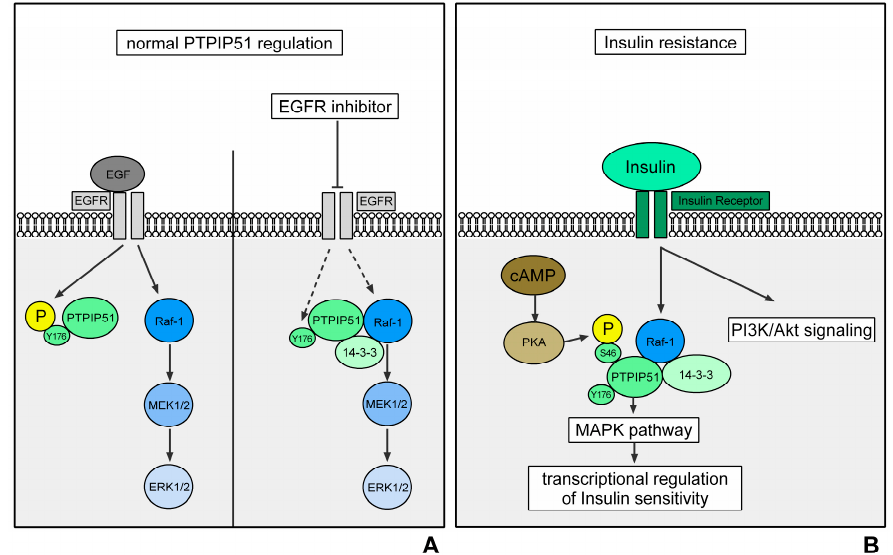
Figure 1. Regulation of PTPIP51 interactions in normal cells (represented by the HaCat cell line). Activation of the EGFR via the binding of EGF induces an activation of Raf-1 via several signaling molecules. Raf-1 depicts the MAPKKK of the ERK signaling. Its activation triggers a signaling cascade via MEK1/2 and ERK1/2, which ultimately initiates transcription. The EGFR also phosphorylates the Tyr176 residue of PTPIP51 and thereby inhibits its interaction with Raf-1. This mechanism prevents an overshooting activation of the MAPK pathway. The right side of the figure represents the interactions when EGFR is inhibited. The inhibition of EGFR leads to an omission of Tyr176 phosphorylation of PTPIP51 via the EGFR. The dephosphorylation of PTPIP51 at Tyr176 induces the formation of the Raf-1/14-3-3 β /PTPIP51 complex and thus a stimulation of the MAPK pathway. This mechanism partially compensates for the EGFR inhibition (black arrows indicate a phosphorylation/activation; dotted black arrows indicate a reduced phosphorylation/activation) ( A ); regulation of PTPIP51 interactions in insulin resistance. Activation of the insulin receptor induces the activation of the PI3K-Akt-mTOR signaling and the MAPK pathway, especially the ERK signaling. Here, PTPIP51 stimulates the signaling on Raf-1 level and potentially modulates the insulin sensitivity on transcriptional level. Protein kinase A (PKA) phosphorylates the Ser46 residue of PTPIP51 and thereby stimulates the binding of PTPIP51 and Raf-1 via 14-3-3 β (black arrows indicate a phosphorylation/activation) ( B ).